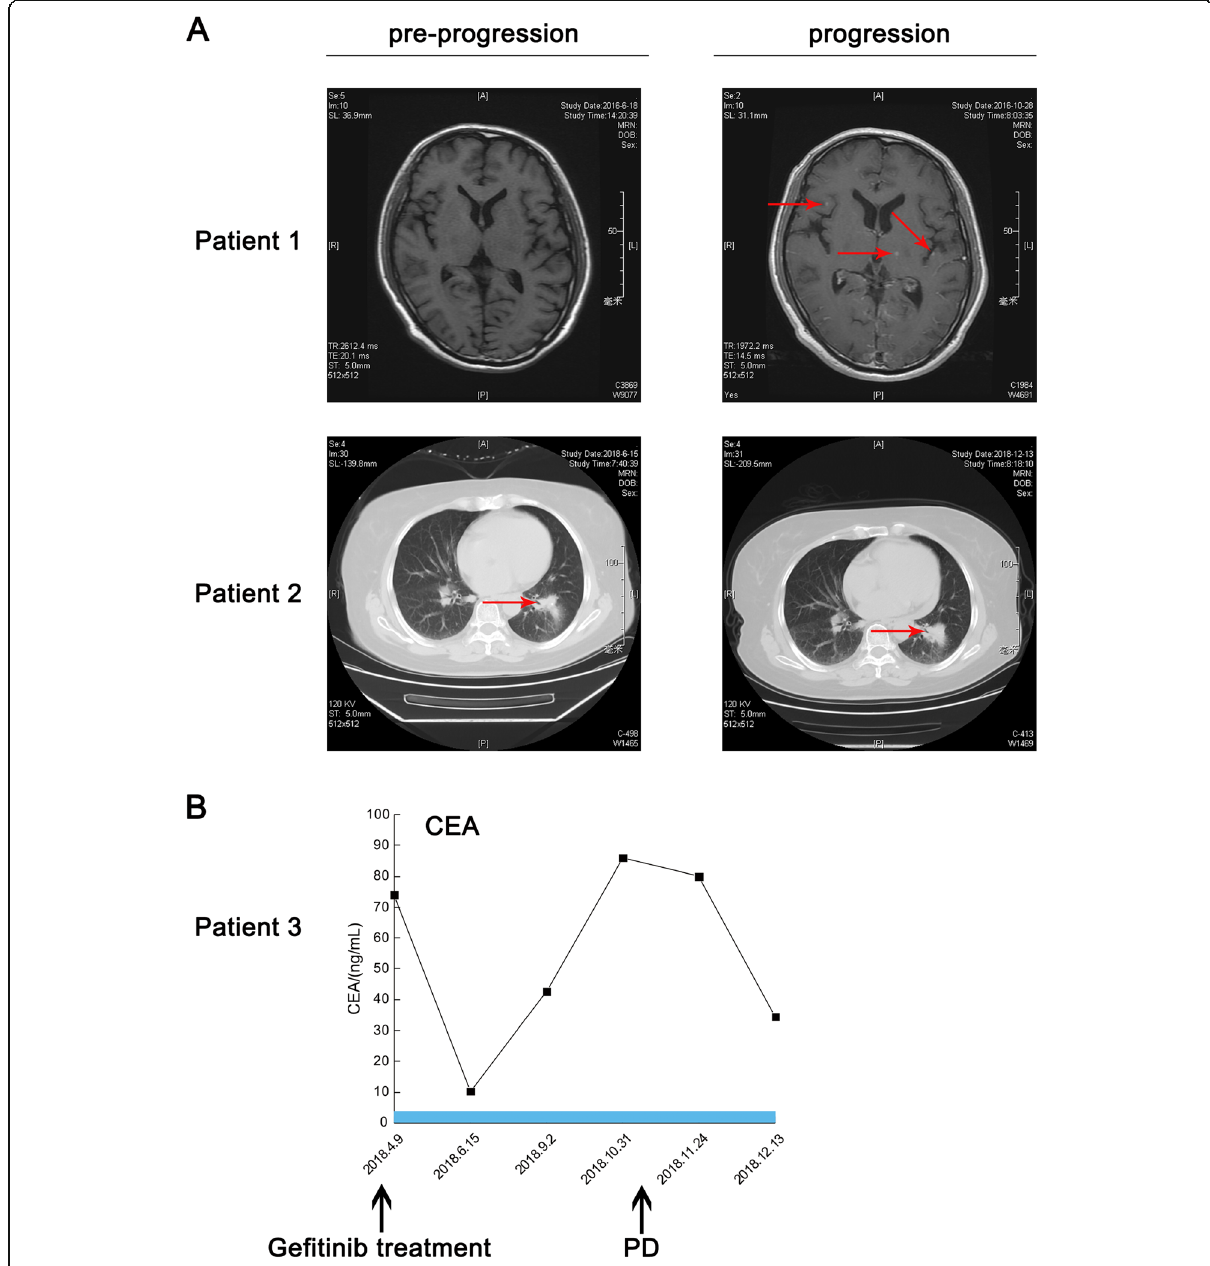
Fig. 1 Basic information for selected patients harboring concurrent alterations of EGFR sensitive mutations and MDM2 amplification. a CT and MRI scans of patients before and after the progression of the disease: new lesions in central nervous system of patient 1 were detected; the primary lesion of patient 2 was evaluated as progressive disease according to RECIST 1.1; b the carcinoembryonic antigen (CEA) change of patient 3 during the treatment process: CEA of patient 3 elevated drastically after approximately 2months of gefitinib